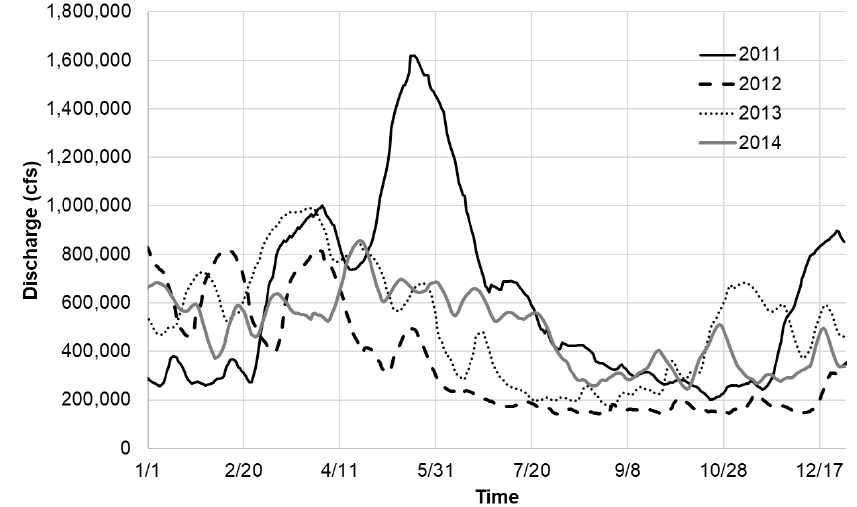
Figure 14. Mississippi River Hydrograph for four modeled years: 2011, 2012, 2013, and 2014. The Delft3D-predicated annual mean salinity for 2011, a high river year, is shown in Figure 15. The upper portion of the modeled Barataria Basin indicates a transition of increasing salinity across Lake Salvador with fresher regions in the northwest of the lake at less than 1 ng/kg. The salinity gradient increases regularly downstream in the basin with the highest salinity values in the southwestern corner of Barataria Basin near Caminada Bay and Grand Isle; these areas are west of the Barataria Waterway and are furthest from any sources of freshwater coming from the Mississippi River.